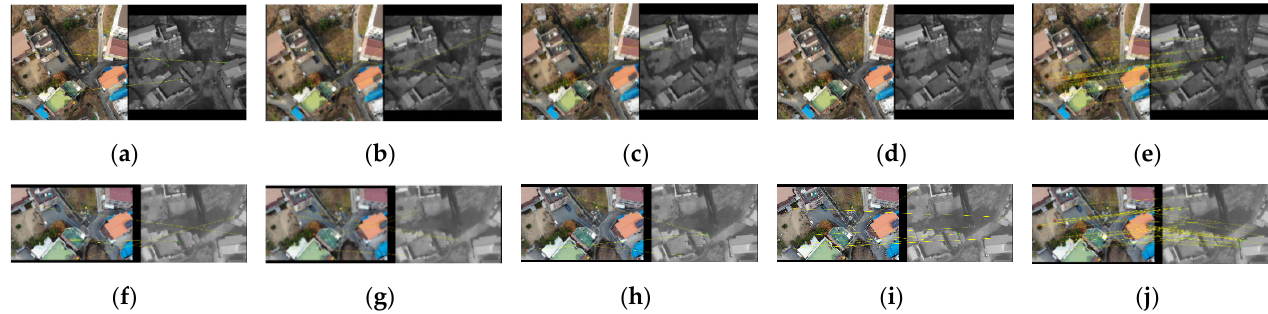
Figure 7. Matching results of building type images: visible nadir-looking (630 × 627) vs. TIR oblique (640 × 512) case: ( a ) SIFT, ( b ) SURF, ( c ) SAR–SIFT, ( d ) ASIFT, and ( e ) proposed method; visible oblique (731 × 433) vs. TIR nadir-looking (635 × 436) case: ( f ) SIFT, ( g ) SURF, ( h ) SAR–SIFT, ( i ) ASIFT, and ( j ) the proposed method.